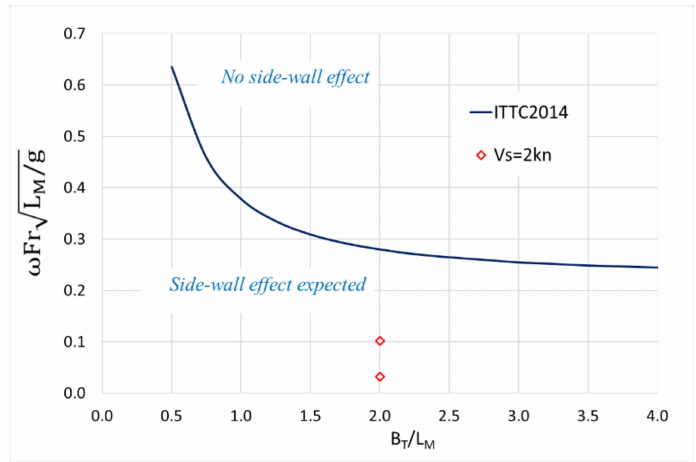
Figure 4. Frequency at which tank interference occurs in head